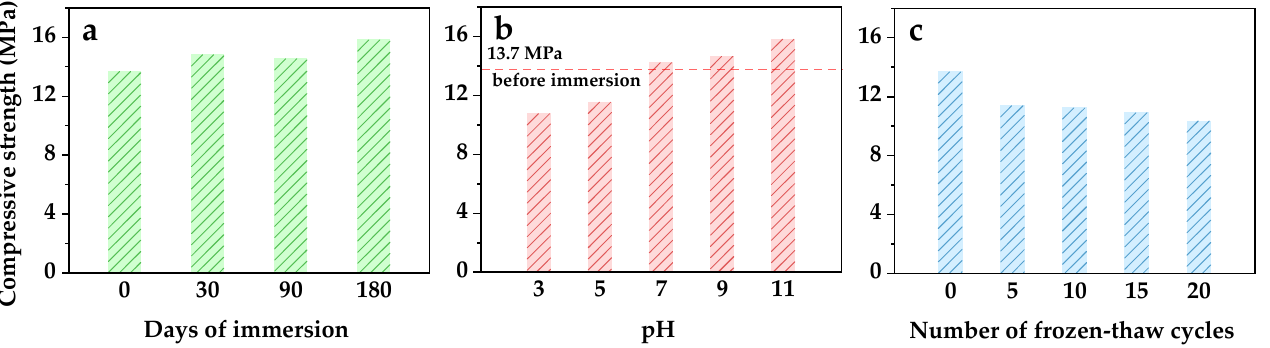
Figure 2. Compressive strength of optimized solidified wasteforms after ( a ) immersion of different days (pH = 7, 25 ± 5 °C), ( b ) 90 day immersion under different pH (25 ± 5 °C), and ( c ) freeze–thaw cycles, with the mixture composition of spent resin 40 wt.%, sulfoaluminate cement 55.8 wt.%, metakaolin 2.2 wt.%, and naphthalenesulfonate water reducer 2 wt.%.